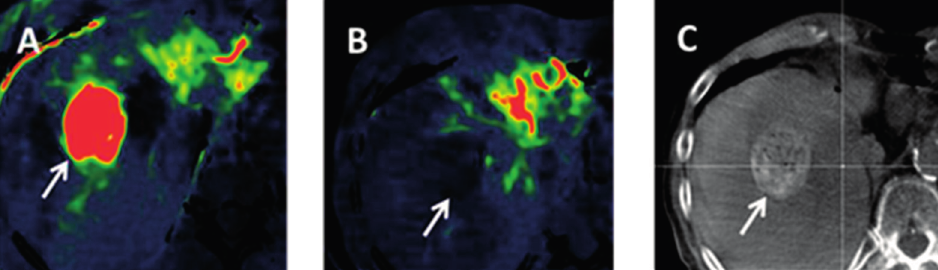
Figure 9. Parenchymal blood volume (PBV) in a HCC lesion before ( A ) and after ( B ) drug eluting bead (DEB) TACE. The tumor volume is marked by the white arrow in all three images; ( B ) shows disappearance of PBV after treatment; ( C ) demonstrates contrast media staining after delivery of beads typically for DEB